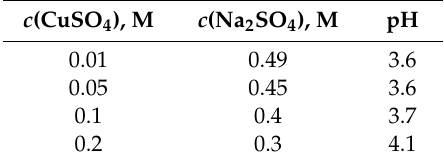
Table 1. Composition of solutions used for electrochemical measurements.